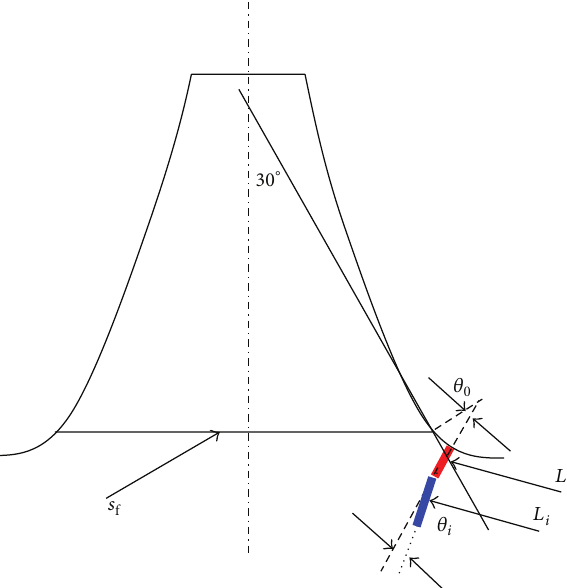
Figure 2: A sketch of influences of crack extensions on dedendum minimum life